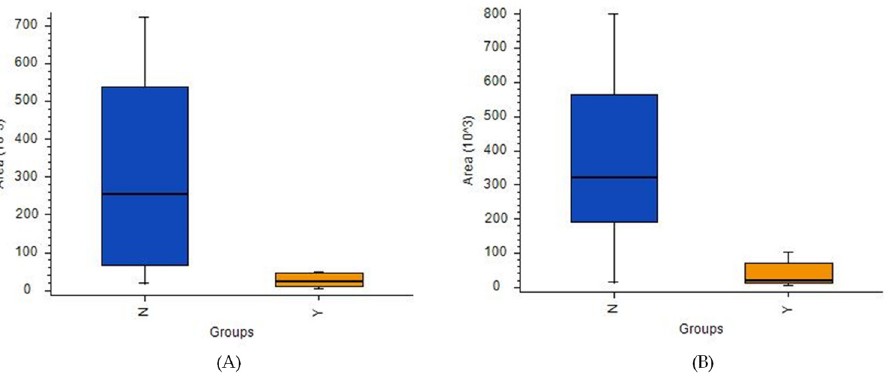
Figure 7. Box-and-whiskers plot for ( A ) propionylcarnitine and ( B ) 2-aminoadipic acid. (Abbrevia- tions: N–IDH wild-type; Y–IDH mutant).